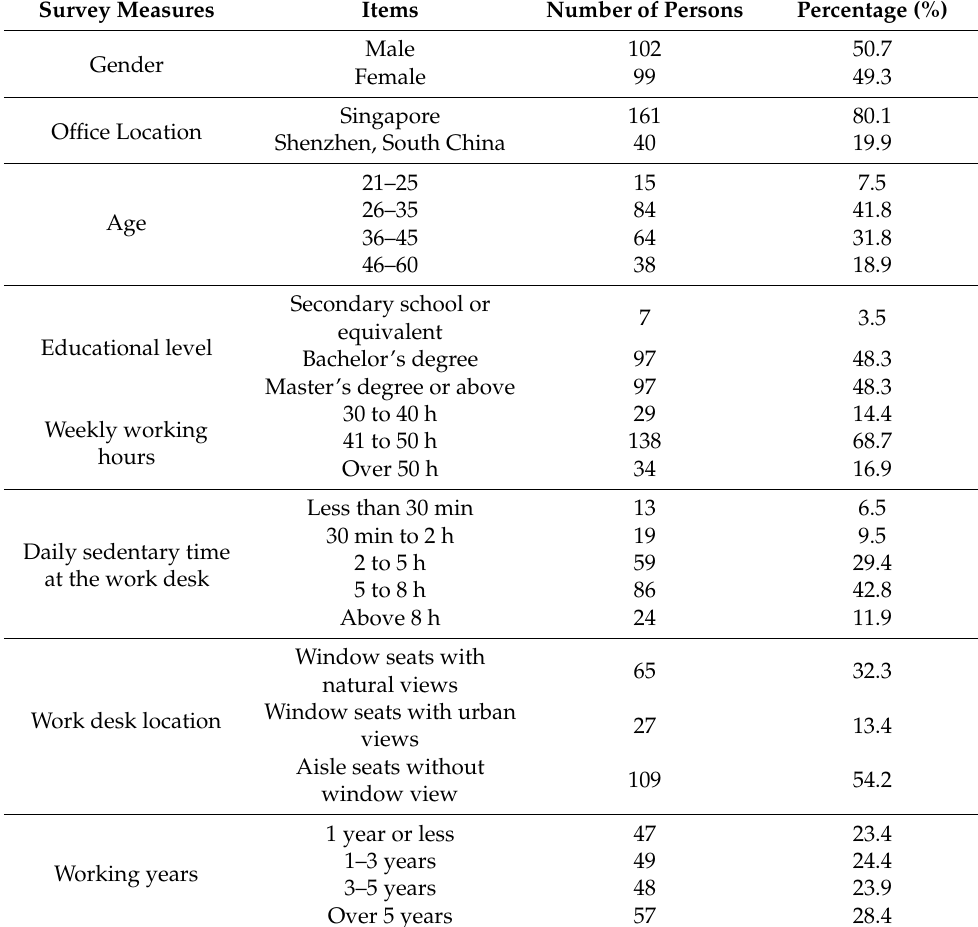
Table 7. Demographic information of survey respondents.